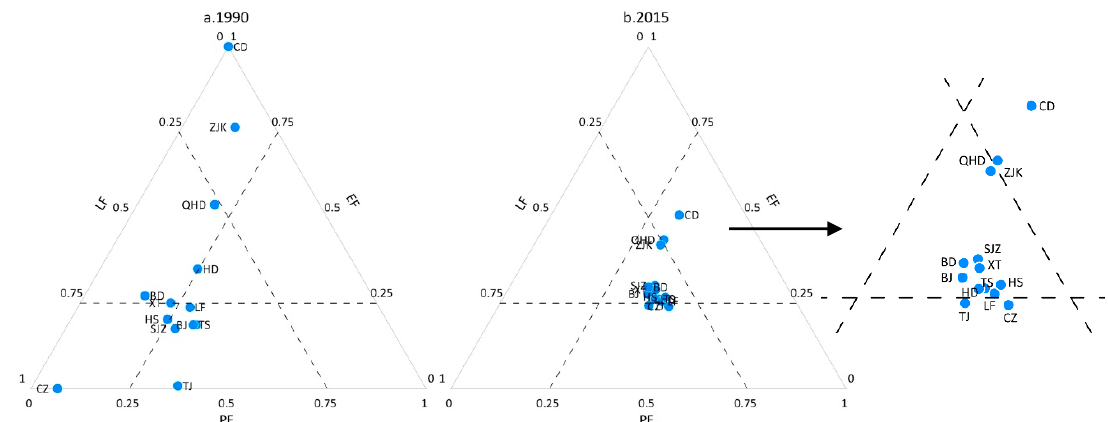
Figure 8. The land use multifunctionality stages of the thirteen cities in 1990 and 2015, with abbreviations as Beijing (BJ); Tianjin (TJ); Shijiazhuang (SJZ); Tangshan (TS); Qinhuangdao (QHD); Handan (HD); Xingtai (XT); Baoding (BD); Zhangjiakou (ZJK); Chengde (CD); Cangzhou (CZ); Langfang (LF); and